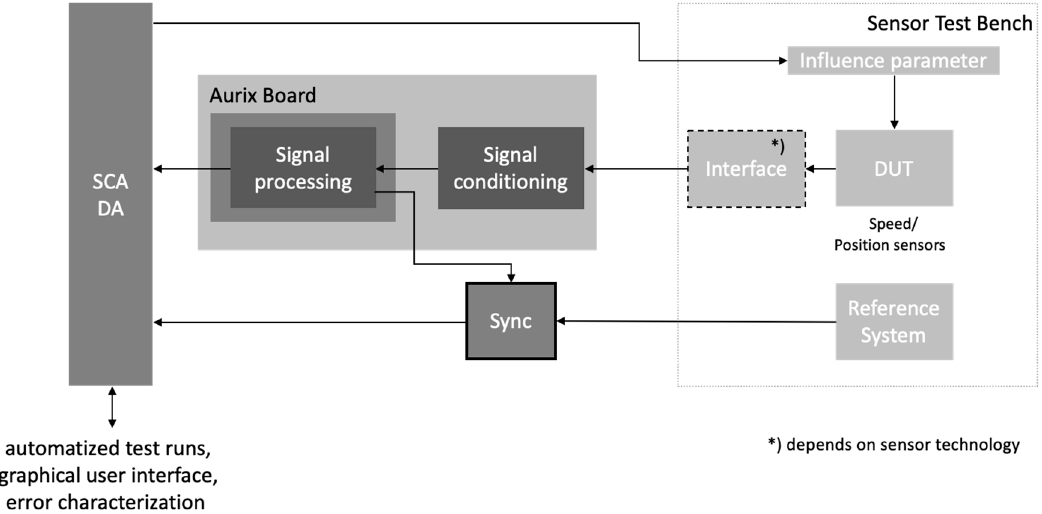
Figure 9. Scheme of synchronizing the system-under-test and the reference system in the presented approach.